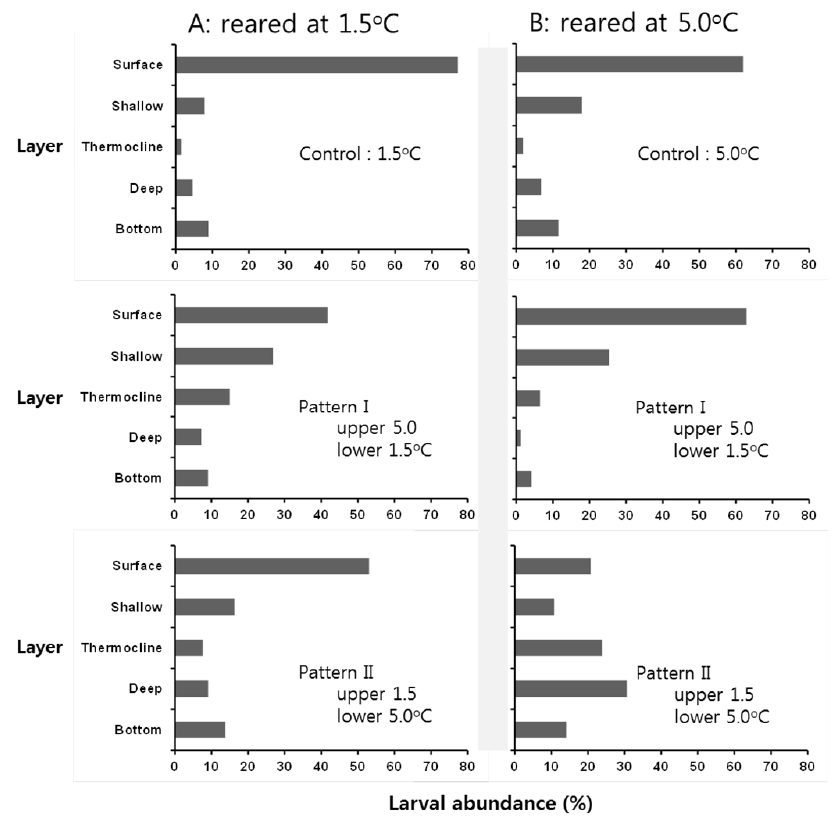
Figure 8. Temporal changes in vertical distributions of walleye pollock larvae at mouth opening stage larvae. Three thermal vertical patterns were used: Control and Patterns I and II. The size of the open circles reflects the number of larvae seen at each time (h) and depth.